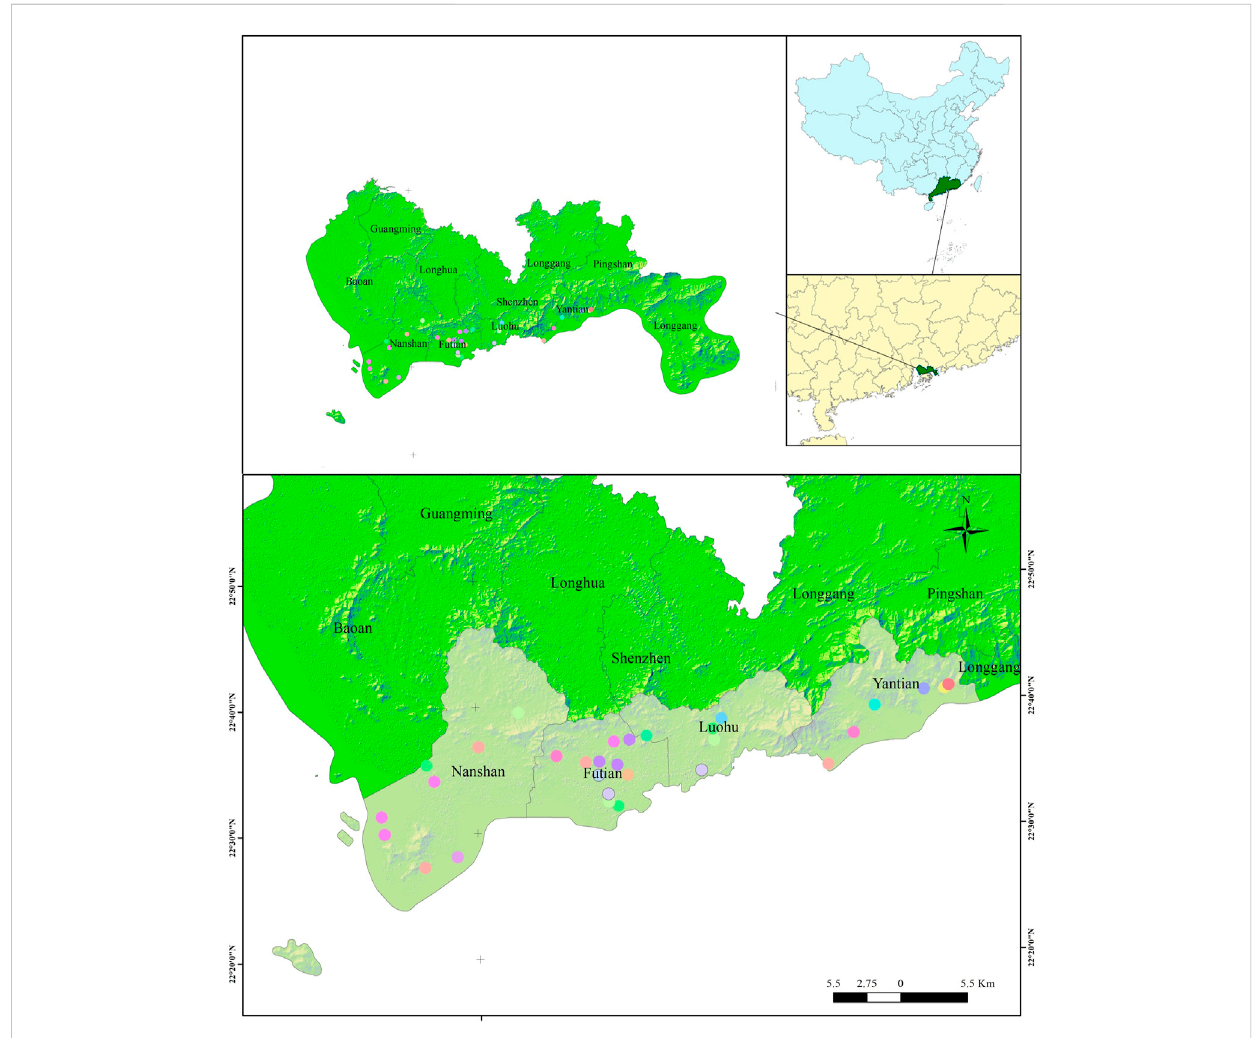
FIGURE 3 Study area of Shenzhen, China.